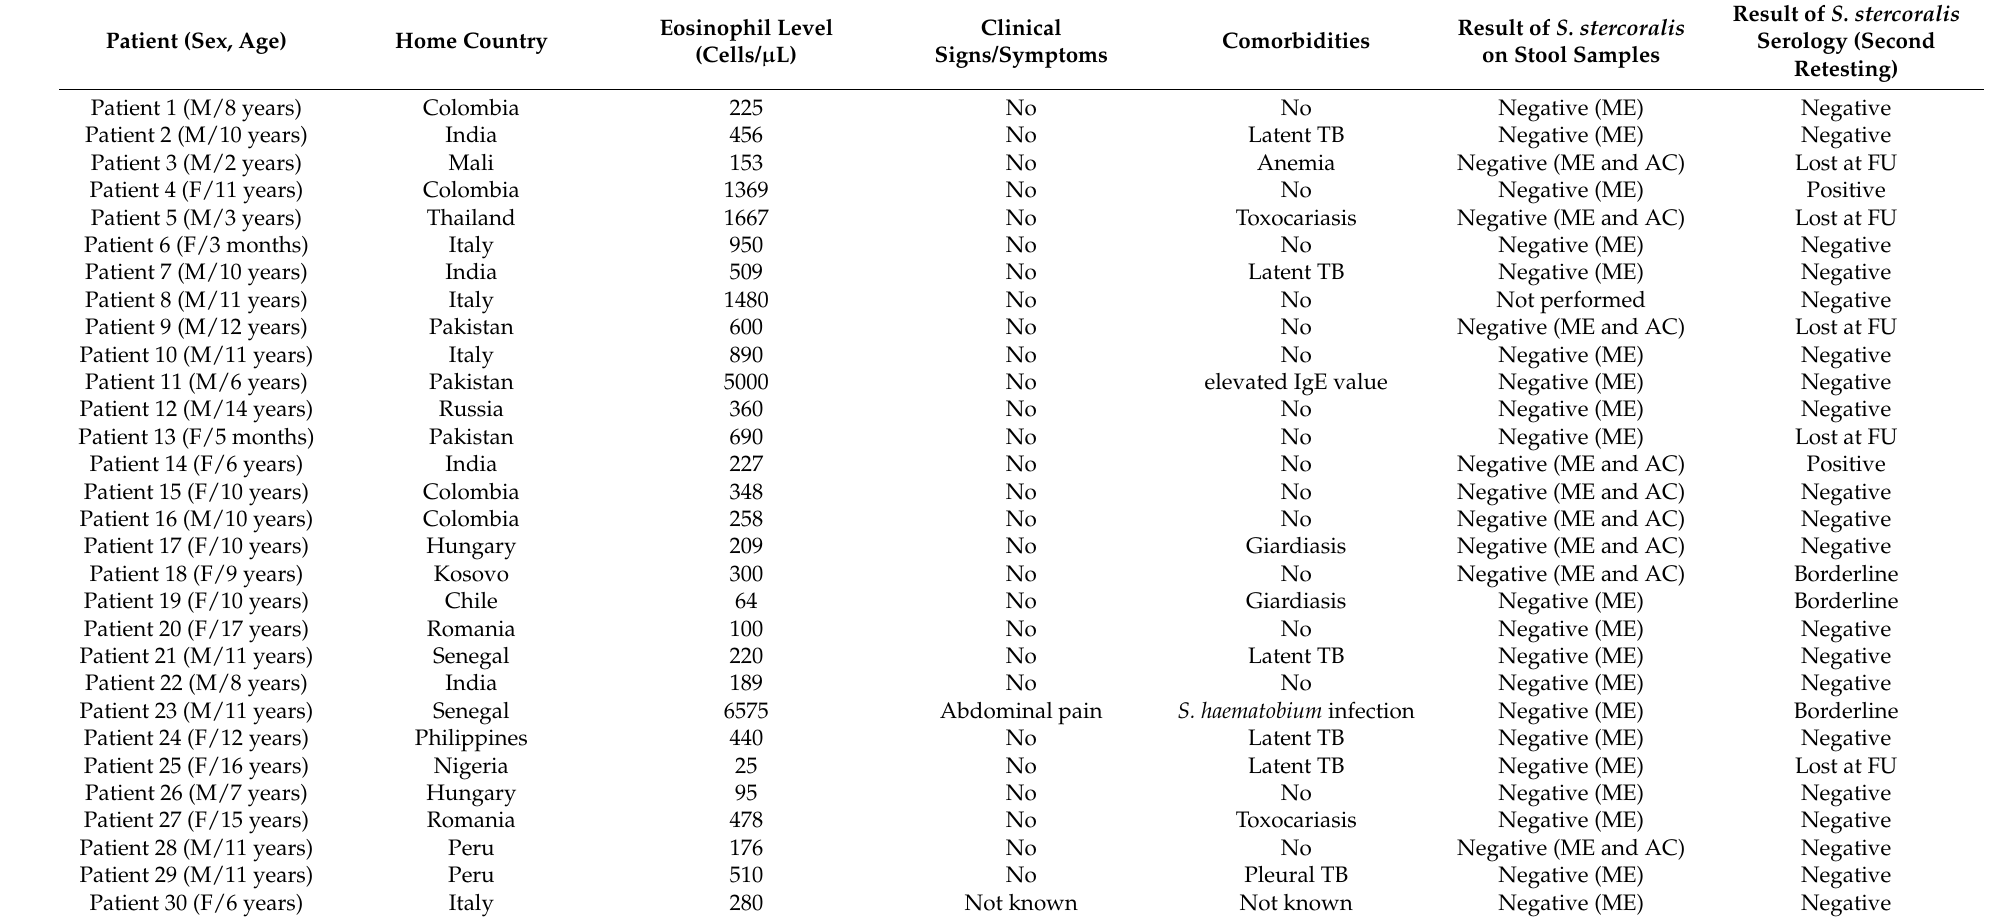
Table 1. Clinical features of patients with borderline S. stercoralis